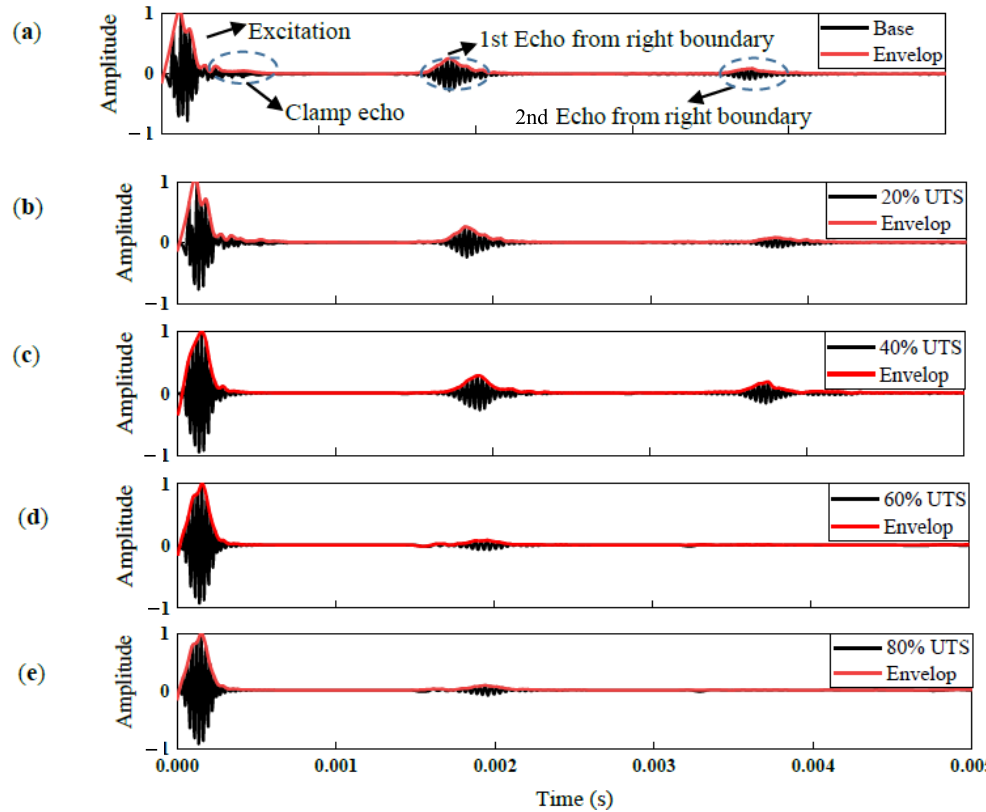
Figure 4. Received signals at different stress levels: ( a ) zero; ( b ) 20% UST; ( c ) 40% UTS; ( d ) 60% UTS; ( e ) 80% UTS.